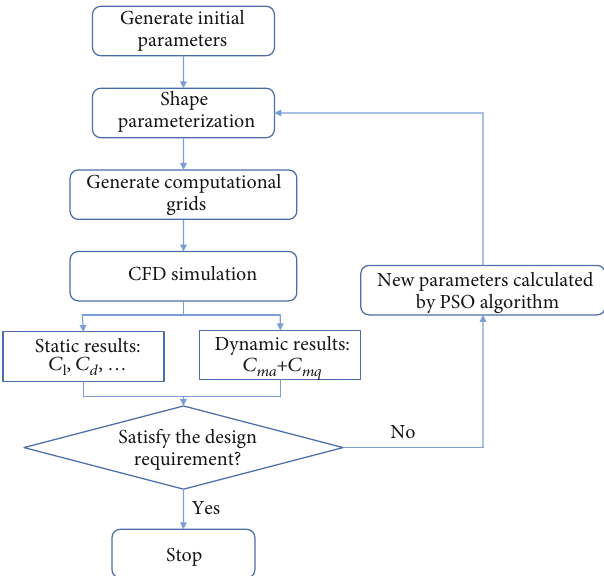
Figure 2: A new aerodynamic optimization design method considering the in fl uence of dynamic